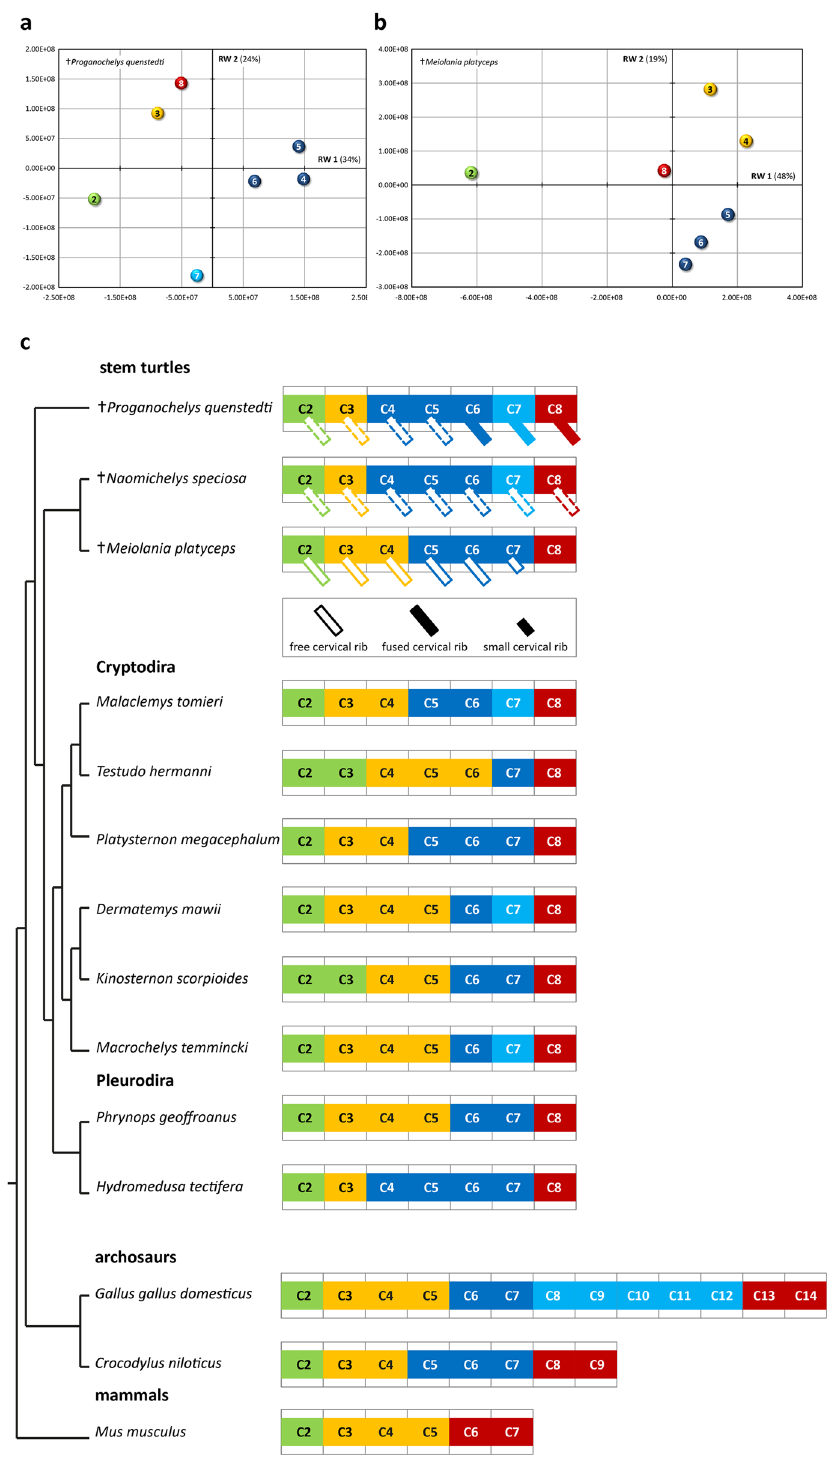
Figure 4. Morphological modularity in turtles. Result of the geometric morphometric analysis of ( a ) the Late Triassic turtle Proganochelys quenstedti and ( b ) the Pleistocene turtle Meiolania platyceps (Supplementary Fig. S1). Plots of the first two Relative Warp (RW) axes. ( c ) Morphological modularity of the neck in stem turtles, Pleurodira and Cryptodira in comparison to the morphological modularity of the neck in crocodile, chicken, and mouse (based on Böhmer et al . 2015b, Böhmer 2017). The color coding indicates morphological clusters of cervical vertebrae; i.e., vertebrae that are more similar to each other than to anterior or posterior vertebrae. In Naomichelys , cervical ribs are not preserved, but they are assumed because of the presence of diaphyses and